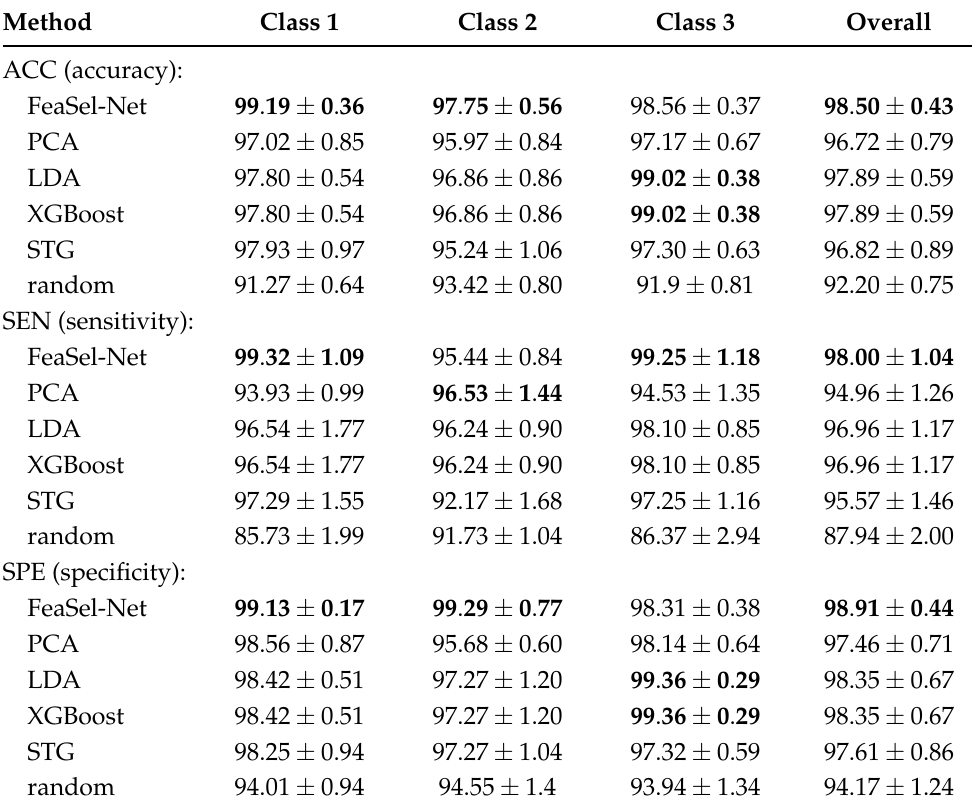
Table A4. Discriminability with masks retrieved from the different FS methods in percentages. Bold values indicate the best